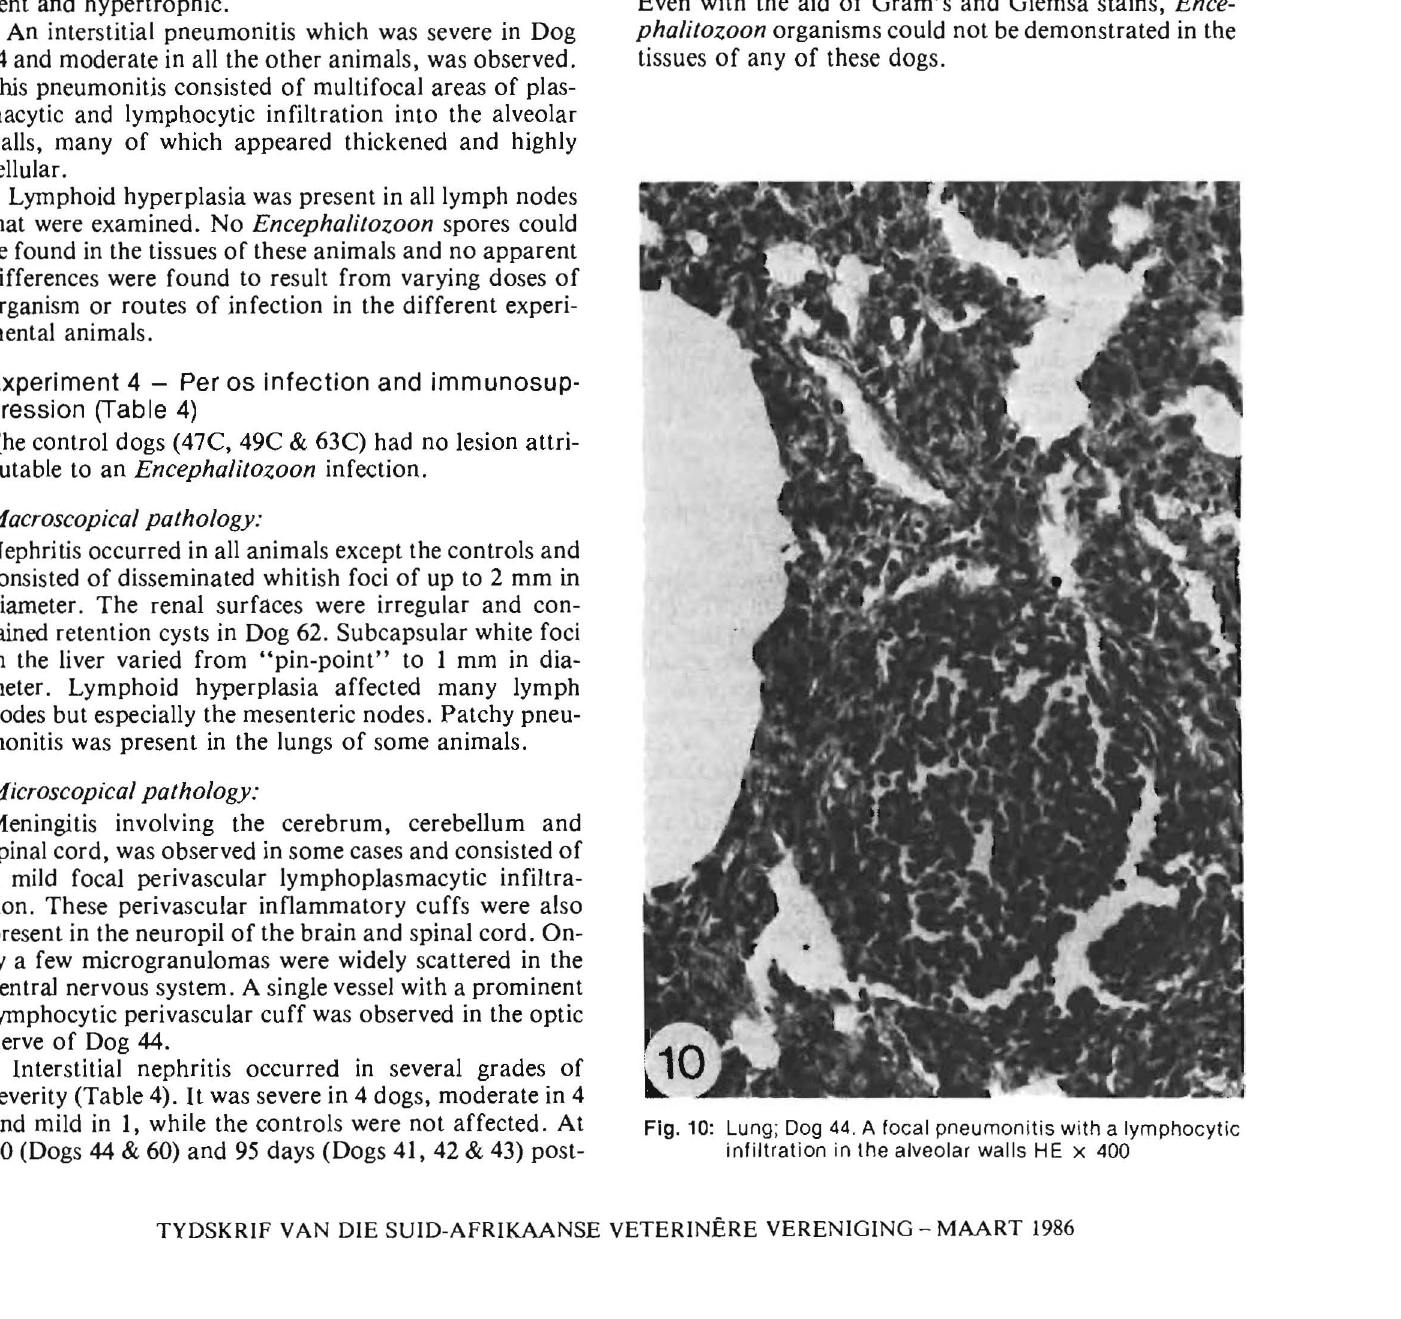
Fig. 10: Lung; Dog 44. A focal pneumonitis with a lymphocytic infiltration in the alveolar walls HE x